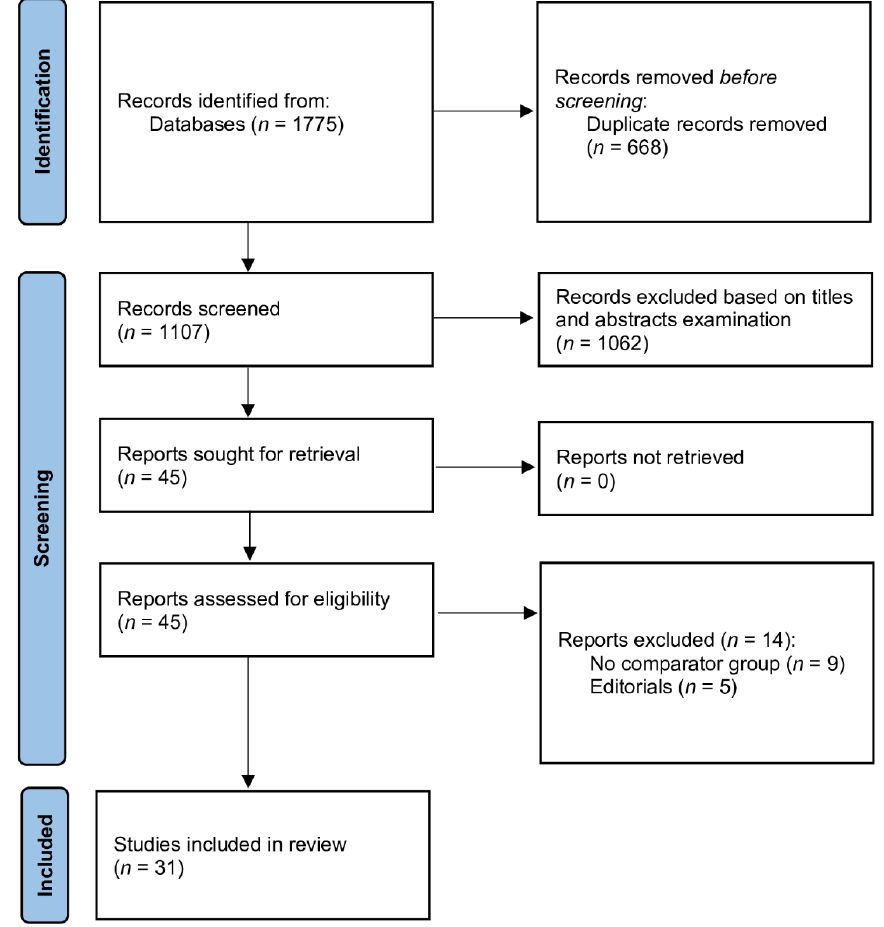
Figure 1. Database search and selection of studies according to PRISMA guidelines.